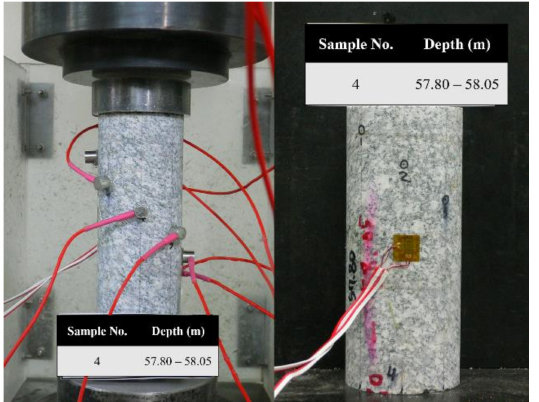
Figure 3. Ten granite specimens to be used in the compression test. These were obtained from the RG-2 section in KURT which comprises Mesozoic two-mica granite.